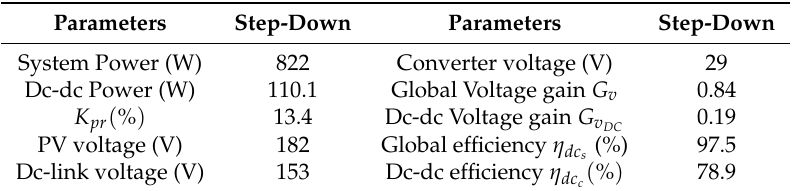
Figure 11. Experimental efficiency curves for: ( a ) Step-down Full-bridge based PPC, for string inverter; ( b ) Isolated dc–dc full-bridge converter. Table 2. Experimental results obtained for a particular evaluation